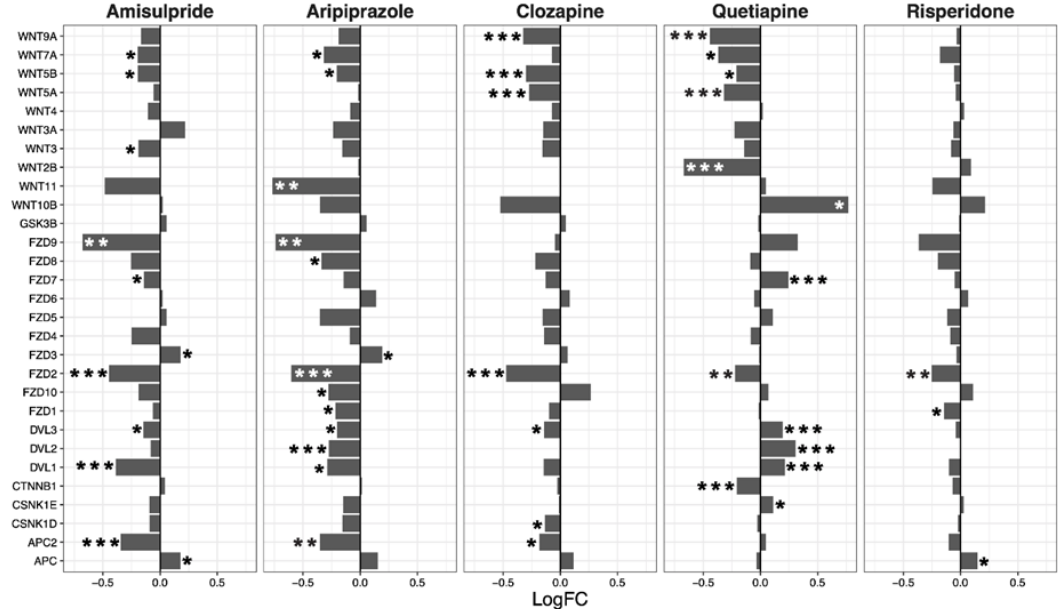
Figure 2. Wnt signaling pathway genes regulated by psychotropic drug treatment in NT2-N cells expressed as log fold change relative to vehicle-treated cells. * p < 0.05, ** p < 0.005, and *** p <